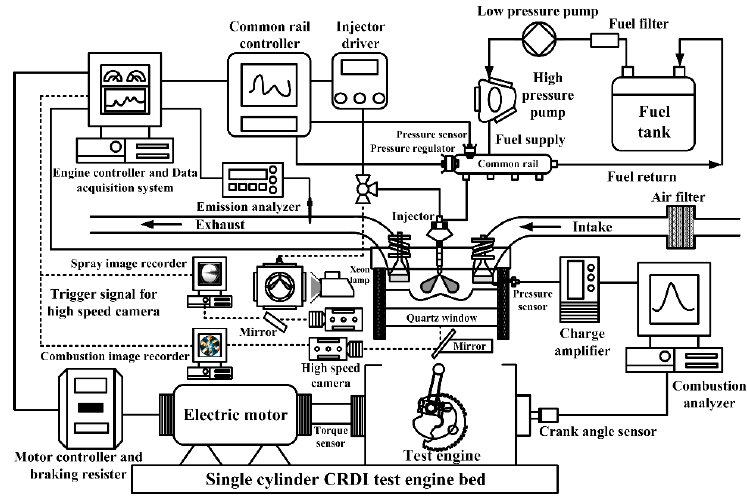
Figure 1. Diagram of the experimental device configuration. Table 1. Main specifications of the test